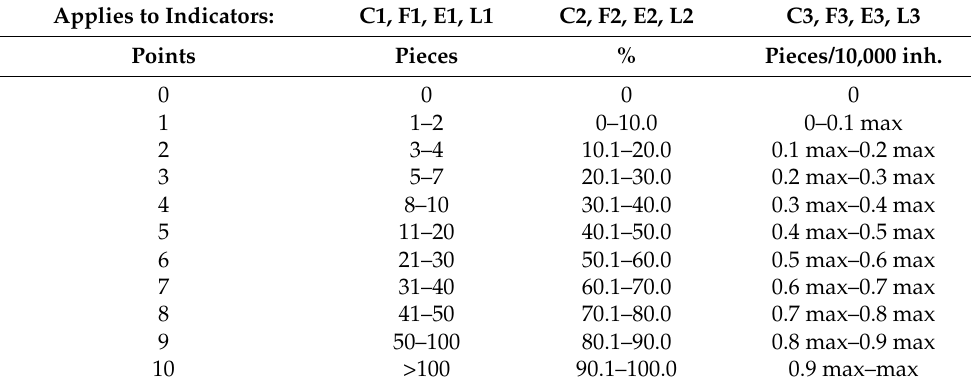
Table 4. Valuation criteria for individual indicators (scoring procedure).